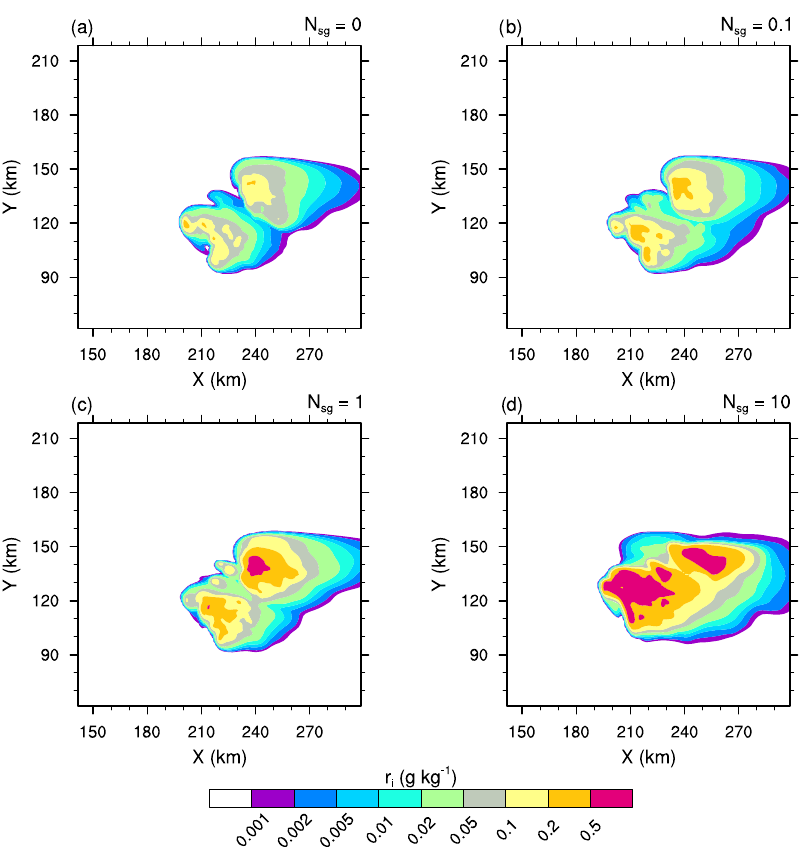
Figure 3. Mixing ratios of the cloud ice ( r i in log scale) of the STERAO simulations at 12km height, where panels (a) – (d) refer to cases with N sg = 0 . 0, 0.1, 1.0, and 10.0 ice fragments per collision, respectively. The plots are for a fraction of the computational